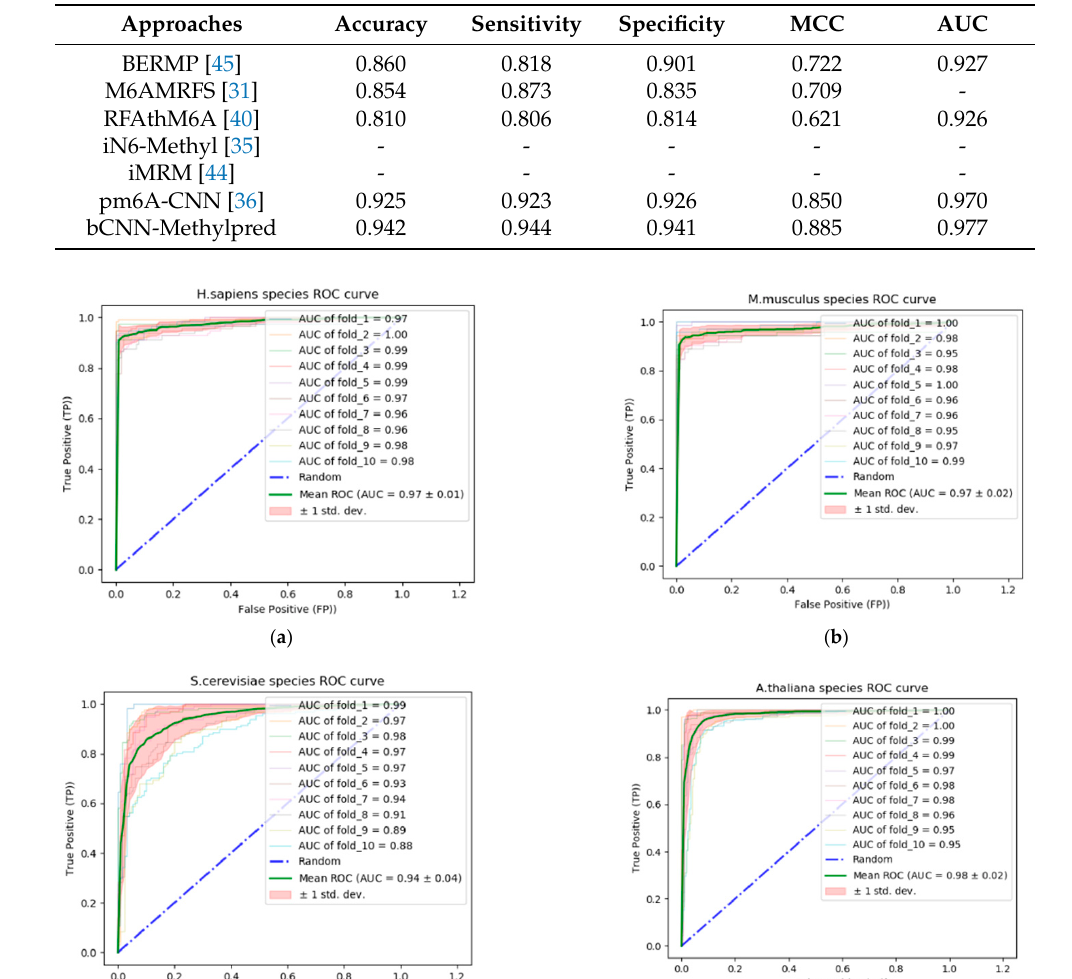
Table 10. Comparison of m6A site prediction using proposed and state-of-the-art approaches based on A. thaliana species.